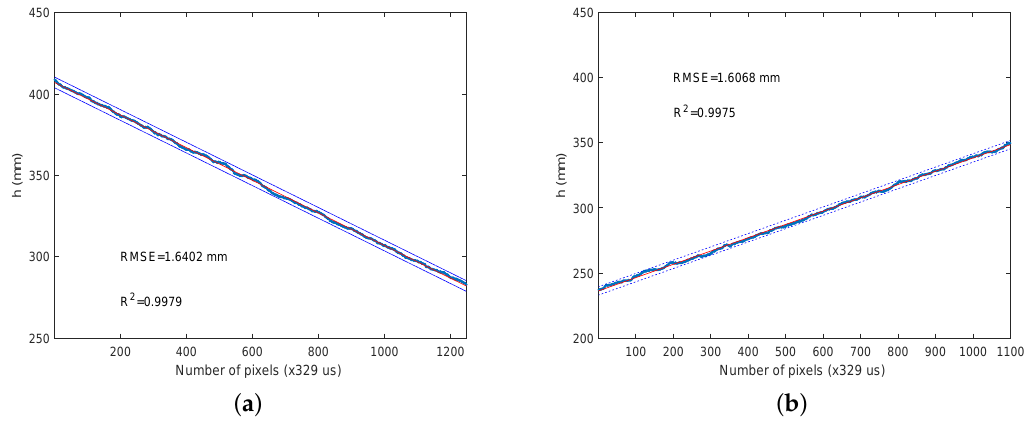
Figure 11. ( a ) Approaching a brown paperboard experiment; ( b ) moving away from a brown paperboard